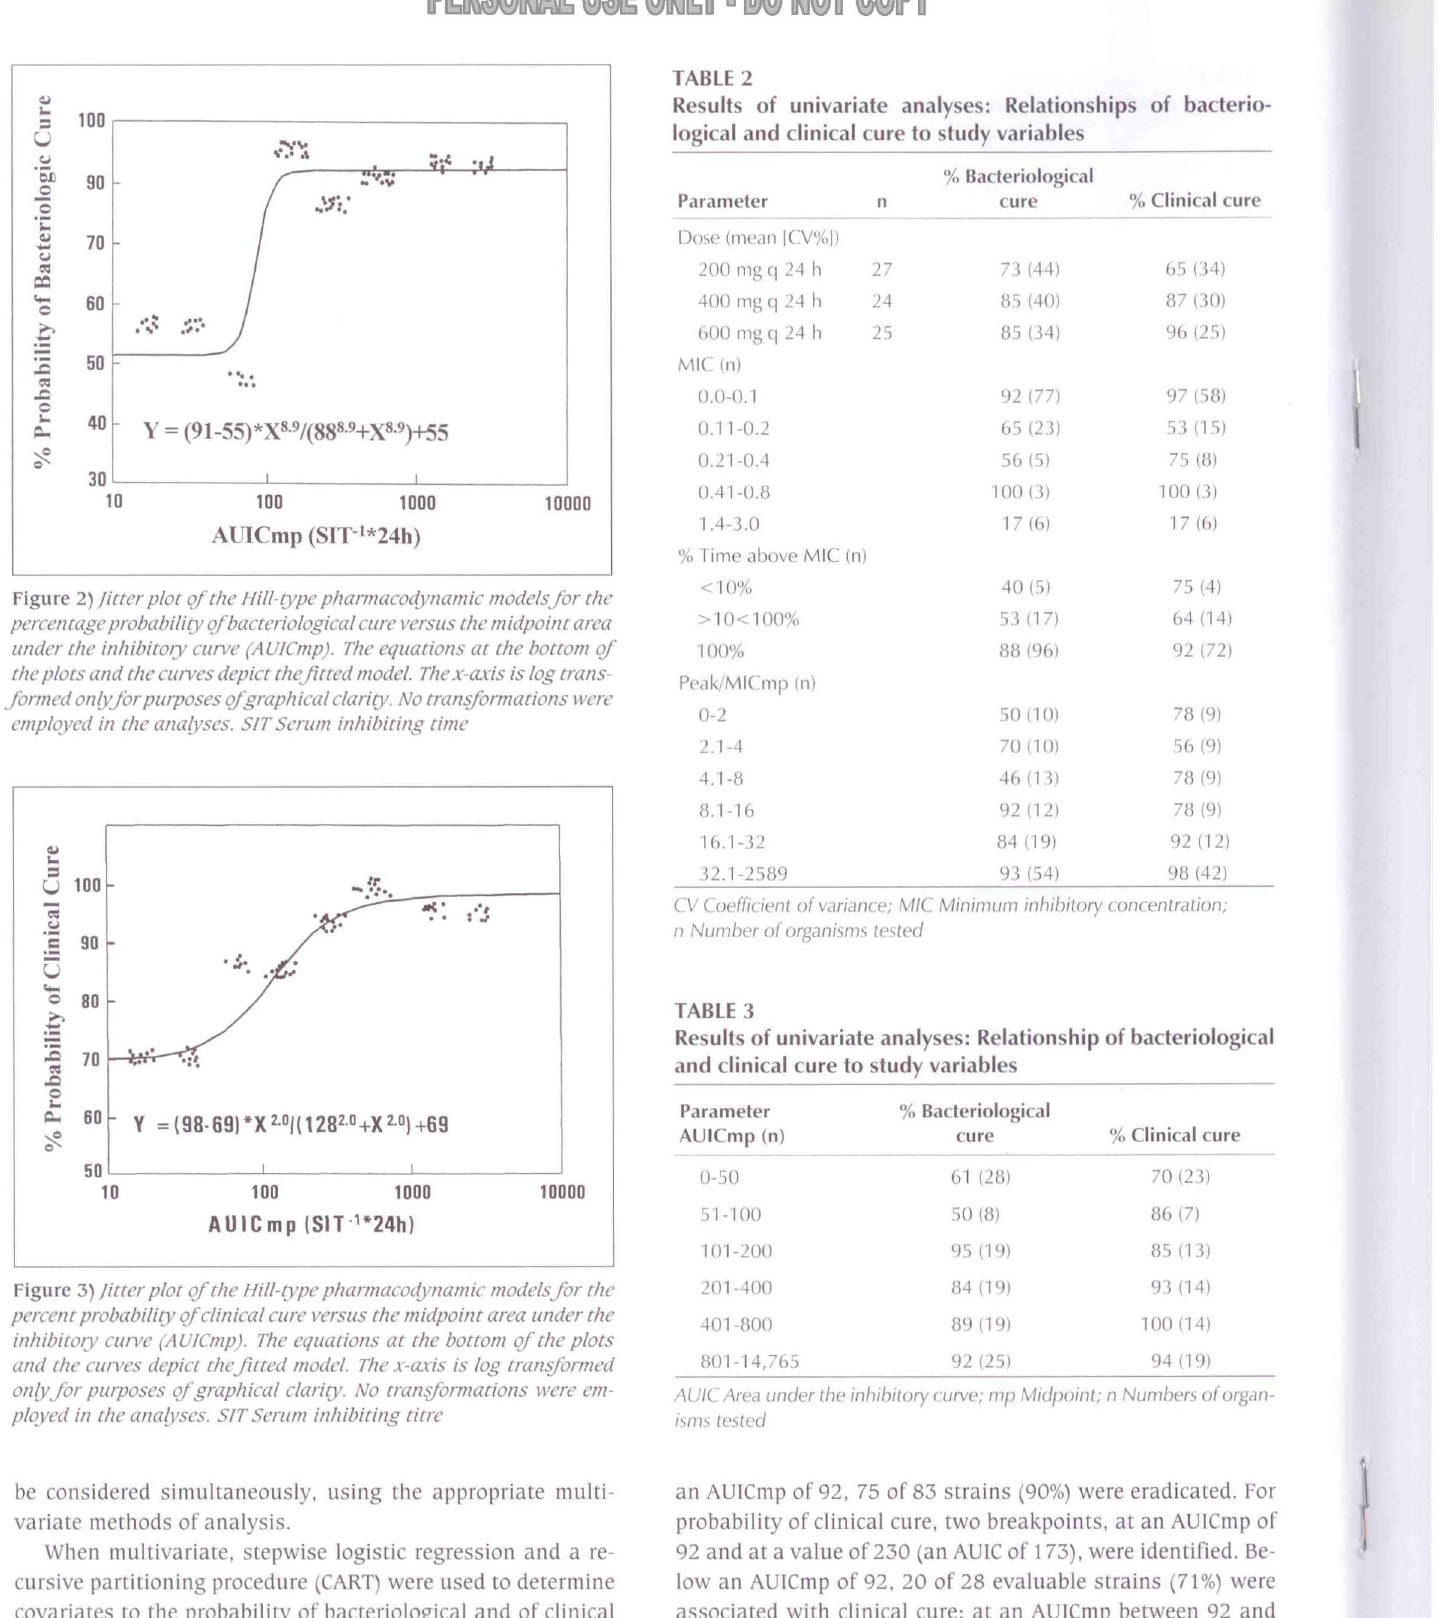
Results of univariate analyses: Relationship of bacteriological and clinical cure to study